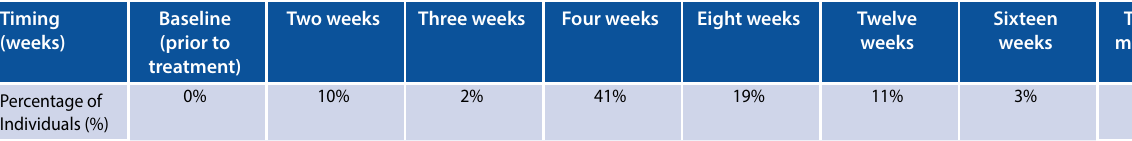
Table 3: Timing of first audiological testing post initial treatment ( n = 124) Timing (weeks)